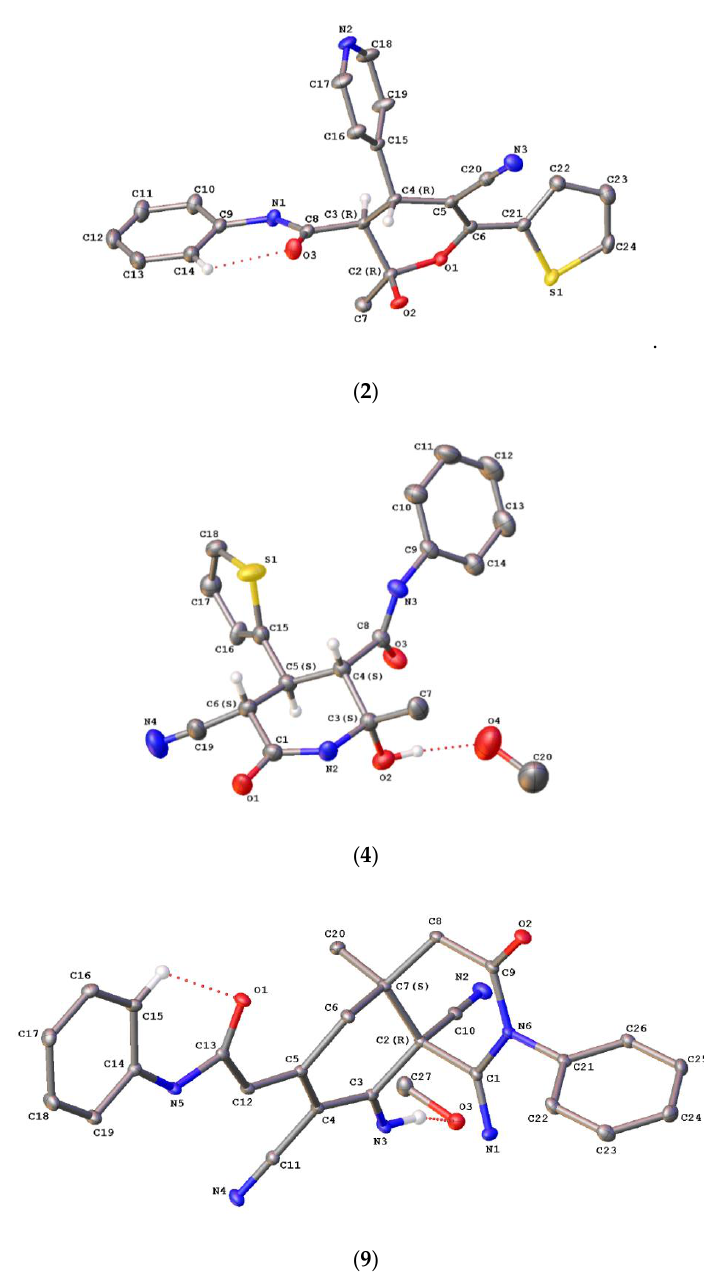
All compounds have stereogenic centers and their relative absolute configurations are depicted in Figure 1. The molecules have a T-shaped ( 2 ) and V-shaped ( 4 and 9 ) form with the polysubstitued central rings as the junction point (Figure 1). According to Cremer & Pople parameters [23], the central rings for each compound have a semi-boat, for compound 2 (Q T = 0.583(2) Å; θ = 124.3(2) ; φ = 267.2(3) ) and semi-chair conformation, for compounds 4 (Q T = 0.506(2) Å; θ = 37.7(3) ; φ = 217.3(5) ) and 9 (Ring C2 / C3 / C4 / C5 / C6 / C7: Q T = 0.4991(18) Å; θ = 52.2(2) 305.7(3) ; Ring C1 / C2 / C7 / C8 / C9 / N6: Q T = 0.4638(18) Å; θ = 131.1(2) ; φ = 353.9(3) ). The analyzed torsion angles between all rings are depicted in Scheme 5 and Table 1.